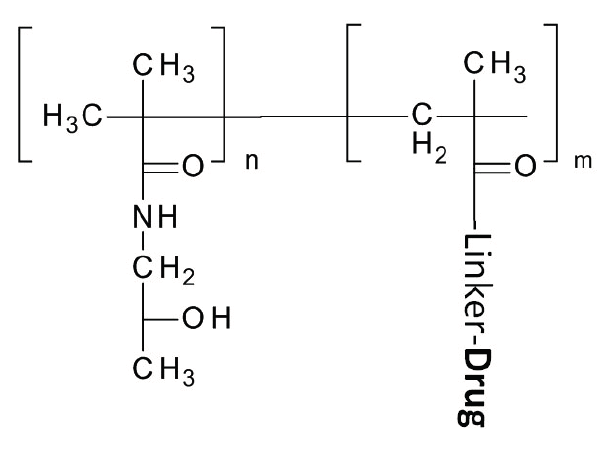
Figure 3. Structure of N -(2-hydroxypropyl) Methacrylamide (HPMA) and its drug